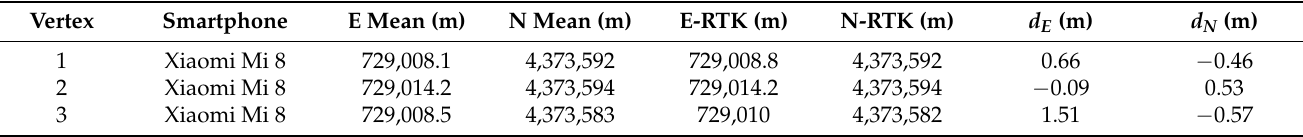
Table 11. Vertices 1, 2, and 3: East, North means of data collected, East, North coordinates from real-time GNSS techniques (E-RTK, N-RTK) and the differences between ( d E , d N ). Vertex